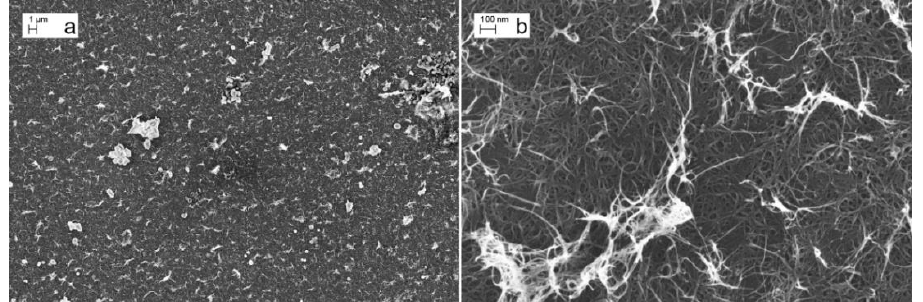
Figure 3. ( a ) SEM image at low magnification of the SWCNT film. The nanotubes cover the substrate surface entirely; it is possible to see some residues of the membrane used for the transfer process. ( b ) SEM image at high magnification of the SWCNT film.